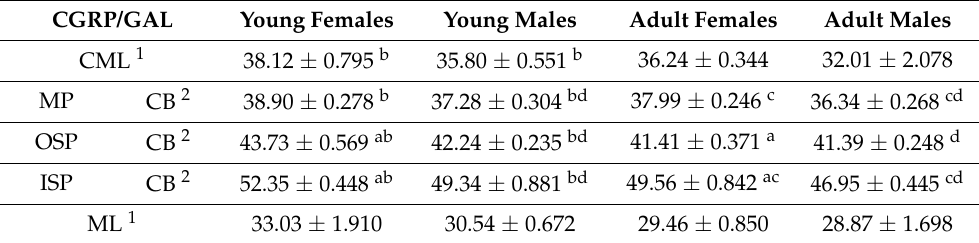
Table 6. The co-localization of CGRP with galanin (GAL) in the enteric nervous structures of the porcine descending colon under physiological conditions in young (10-week old) females and males and adult females and males (Group D). CGRP/GAL Young Females Young